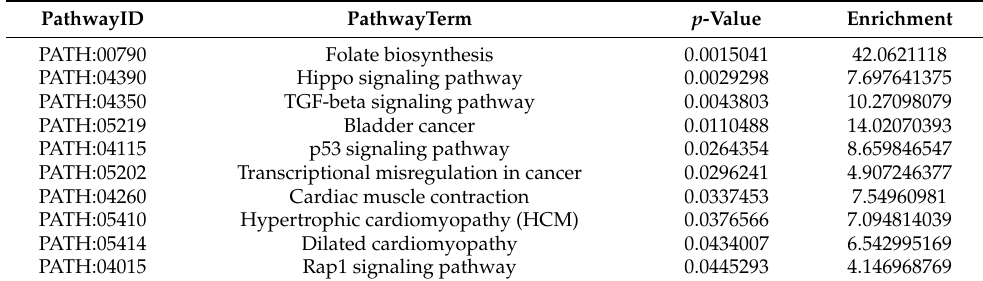
Table 3. KEGG enrichment of down-regulated DEGs show the significantly enriched pathways. The data are ranked according to the p -Value, which indicates the degree of